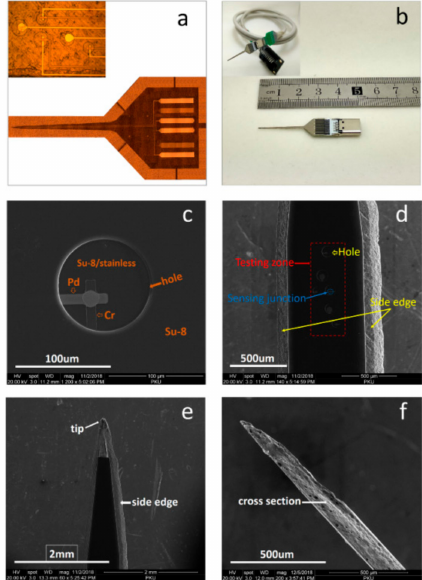
Figure 5. Optical images and scanning electron microscopy images of the as-fabricated device and assembled device. ( a ) Measurement zones on the probe before the etching process. ( b ) A microprobe assembled in an electrical connection socket. ( c ) SEM image of a measurement zone. ( d ) SEM image of